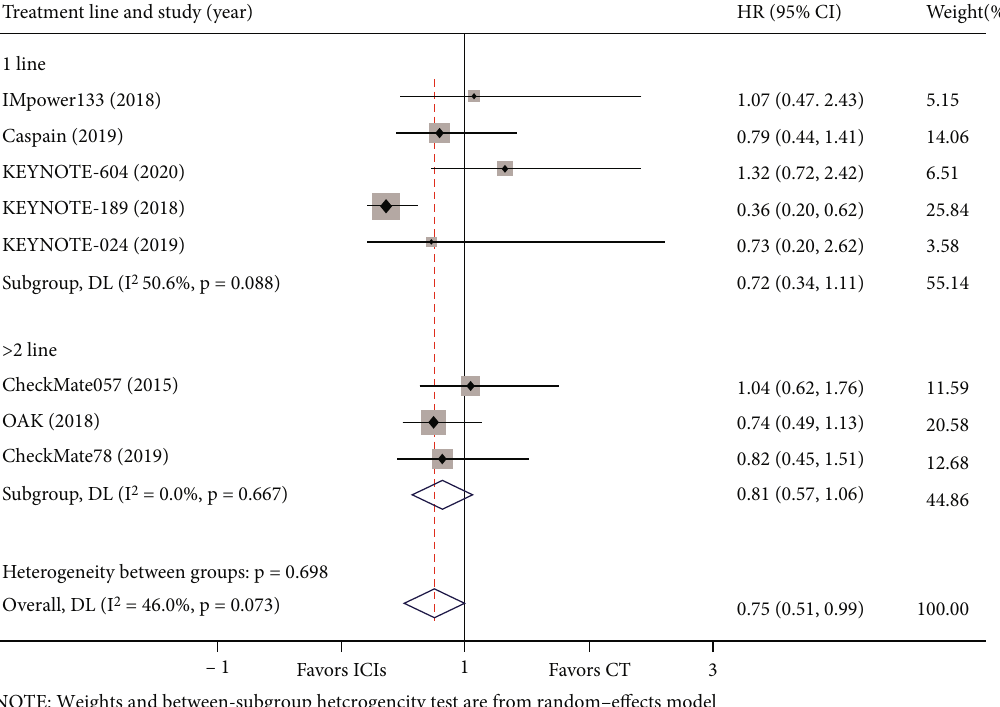
Figure 9: Subgroup analyses of OS by treatment line between the immune checkpoint inhibitors (ICIs) group and the chemotherapy (CT) group for lung cancer with BM.